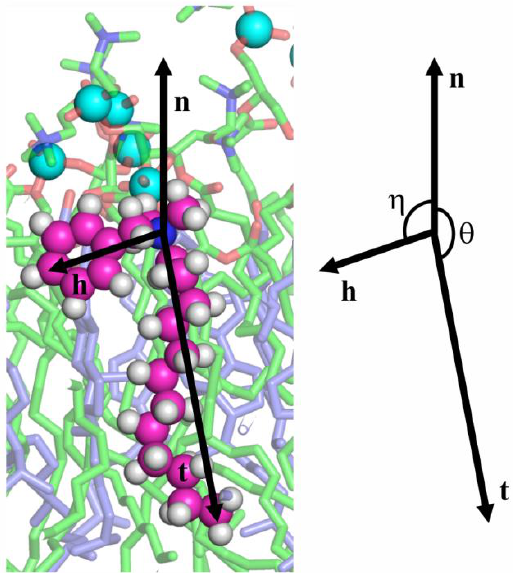
Figure 6. Characterization of hydrophobic ion orientation in a lipid membrane. C, H, and N atoms of the hydrophobic ion are shown as magenta, white, and blue spheres, respectively. Lipids are shown in stick representation, with phosphorus atoms indicated by cyan spheres. DOPC tails are shown as green sticks, cholesterol as blue sticks, O atoms as red sticks, and N atoms of DOPC as blue sticks. n is the unit normal vector to the membrane surface, h is the vector directed from the N + -atom (blue sphere) toward the C-atom in the para position of the aromatic ring, and t is the vector directed from the N + -atom (or from the S-atom of SDS) toward the terminal C-atom in the alkyl tail in the hydrophobic ion. The orientation of the hydrophobic ion is characterized by the angle η between n and h and the angle θ between n and t (the scheme on the right).